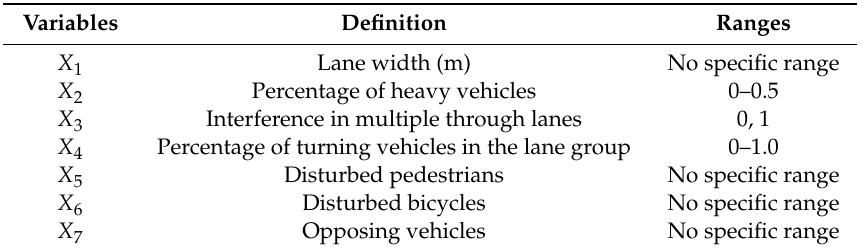
Table 1. Definition of input variables.